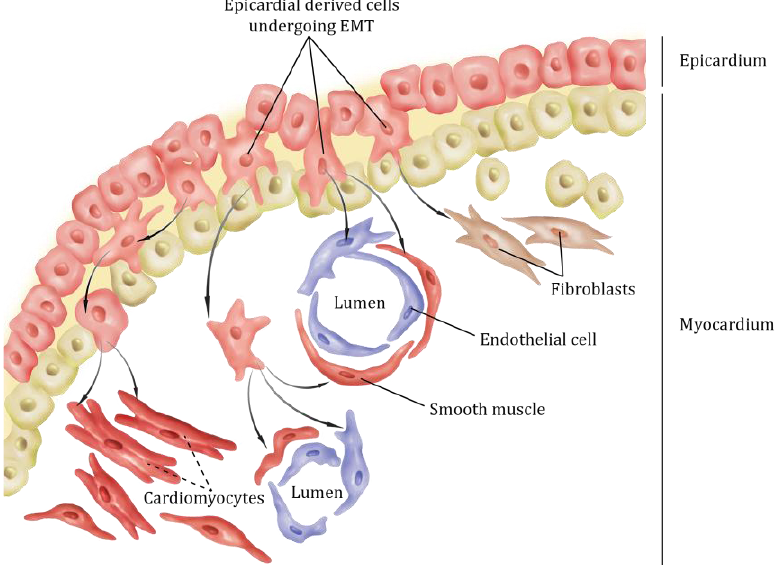
Figure 1. Epicardial derivatives contribute to cardiac lineages. Epicardial cells undergo epithelial-to-mesenchymal transition (EMT), delaminate from the epicardium, invade the underlying myocardium and differentiate into various cardiac lineages, including fibroblasts, smooth muscle cells, endothelial cells and, perhaps, cardiomyocytes.